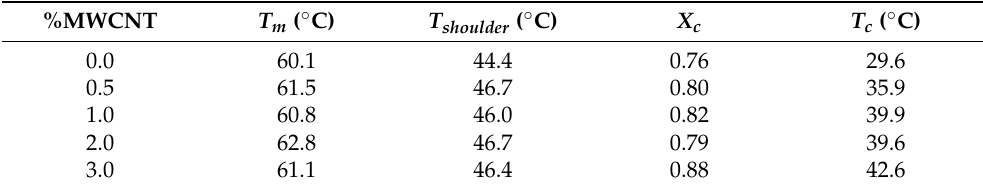
Table 1. Thermal parameters obtained from the first heating and cooling DSC scans of the pre- pared materials.